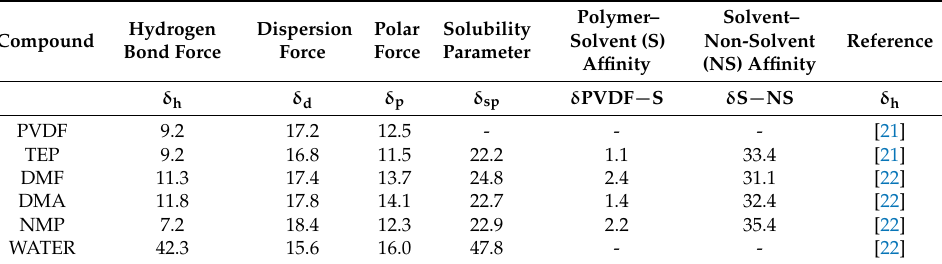
Table 2. Hansen solubility parameters and polymer–solvent